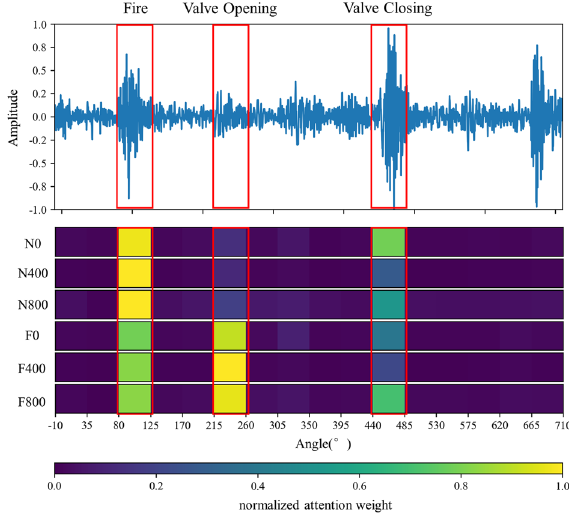
Figure 6. Attention for each working condition on angular domain.